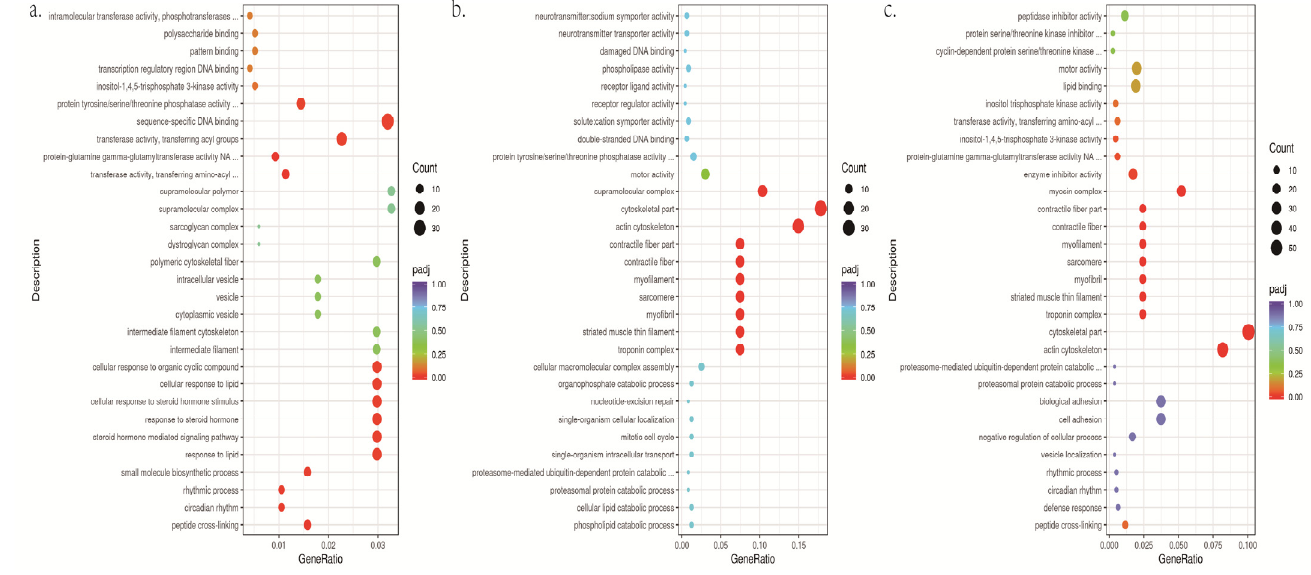
Figure 2. ( a ). The scatter figure of GO enrichment in white vs. yellow. ( b ) The scatter figure of GO enrichment of DEGs in brown vs. yellow. ( c ) The scatter figure of GO enrichment of DEGs in white vs. brown. Count: number of genes in each pathway. GeneRatio: ratio of the number of target genes divided by the total number of genes in each pathway.